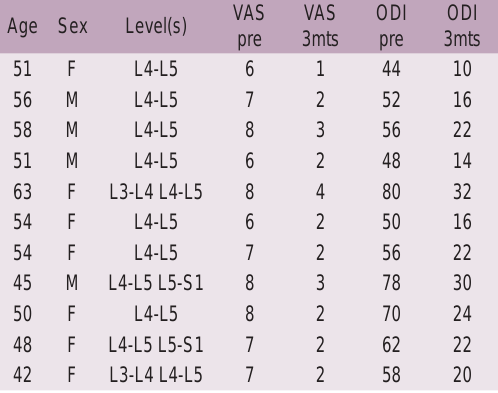
TABLE 1. Clinical Outcomes of the